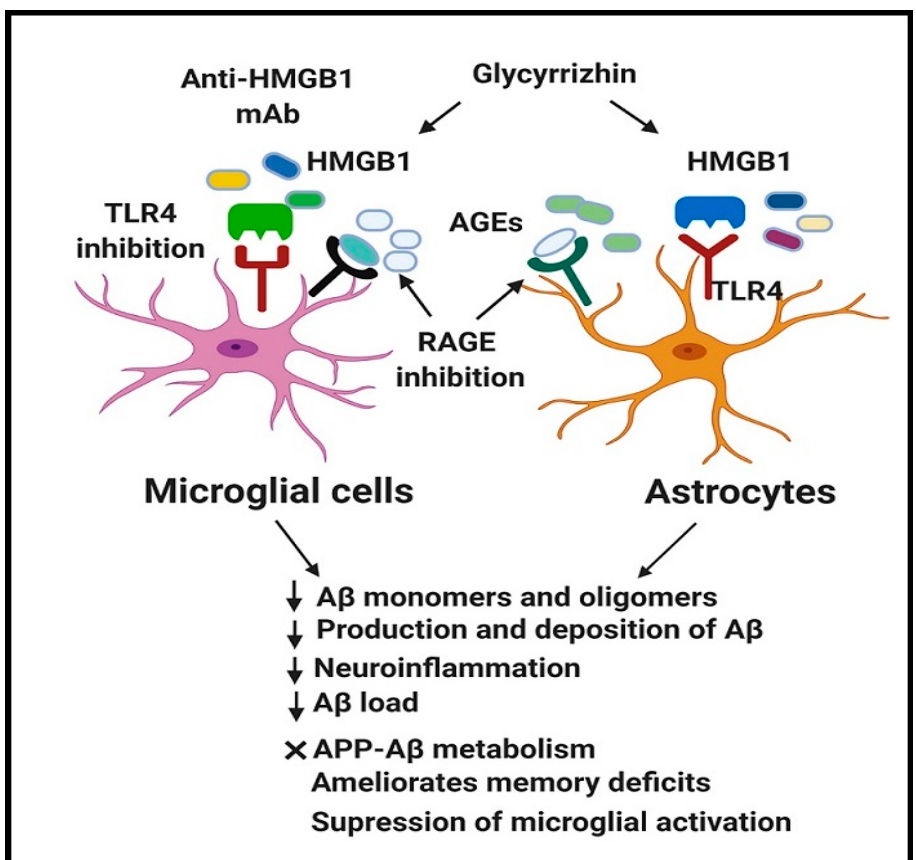
Figure 2. Beneficial effect of HMGB1, RAGE, and TLR4 inhibition in AD.